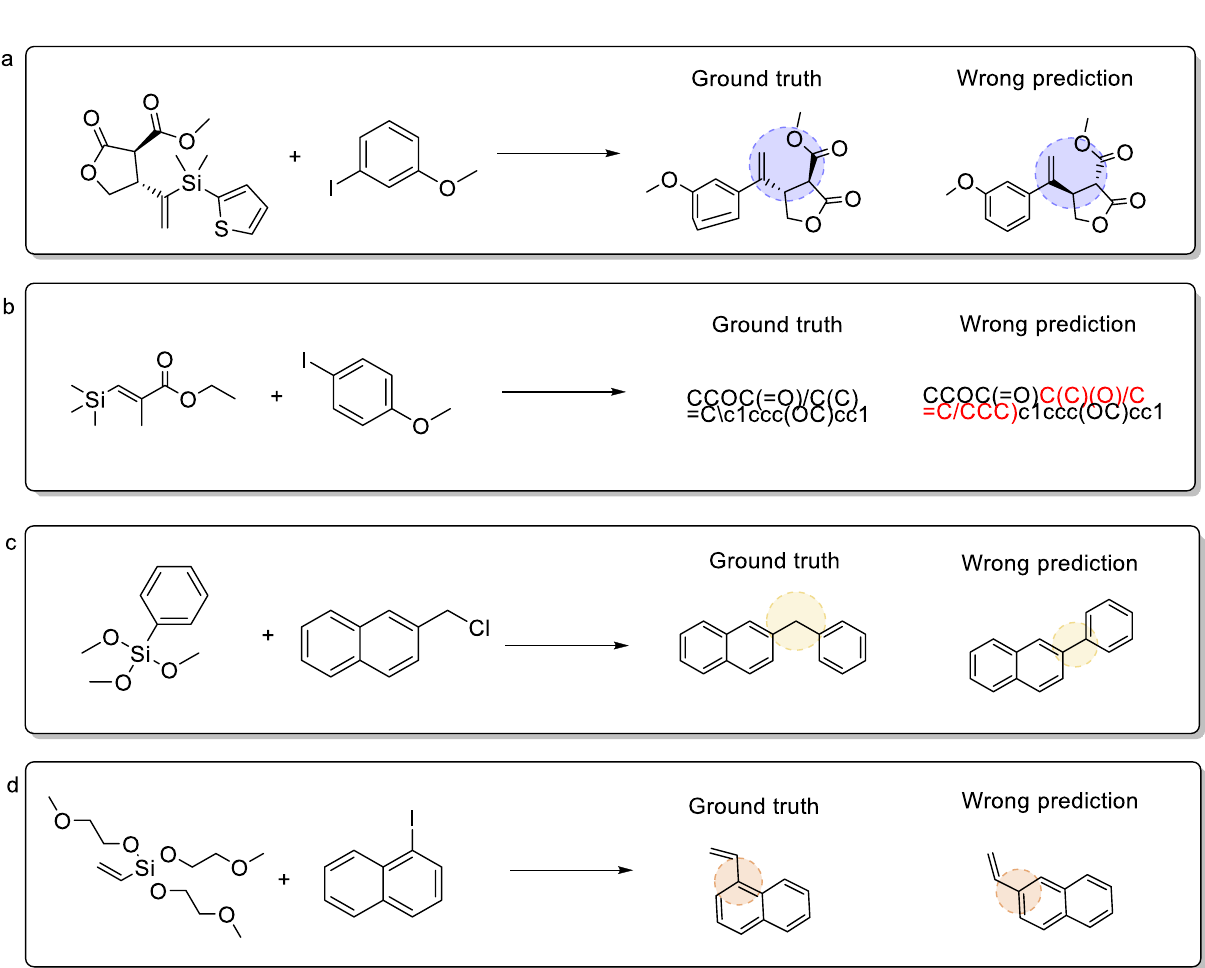
Figure 5. Typical error analysis of Hiyama coupling reactions. ( a ) chirality errors, ( b ) SMILES errors, ( c ) the number of atom errors ( d ) functional group isomerism